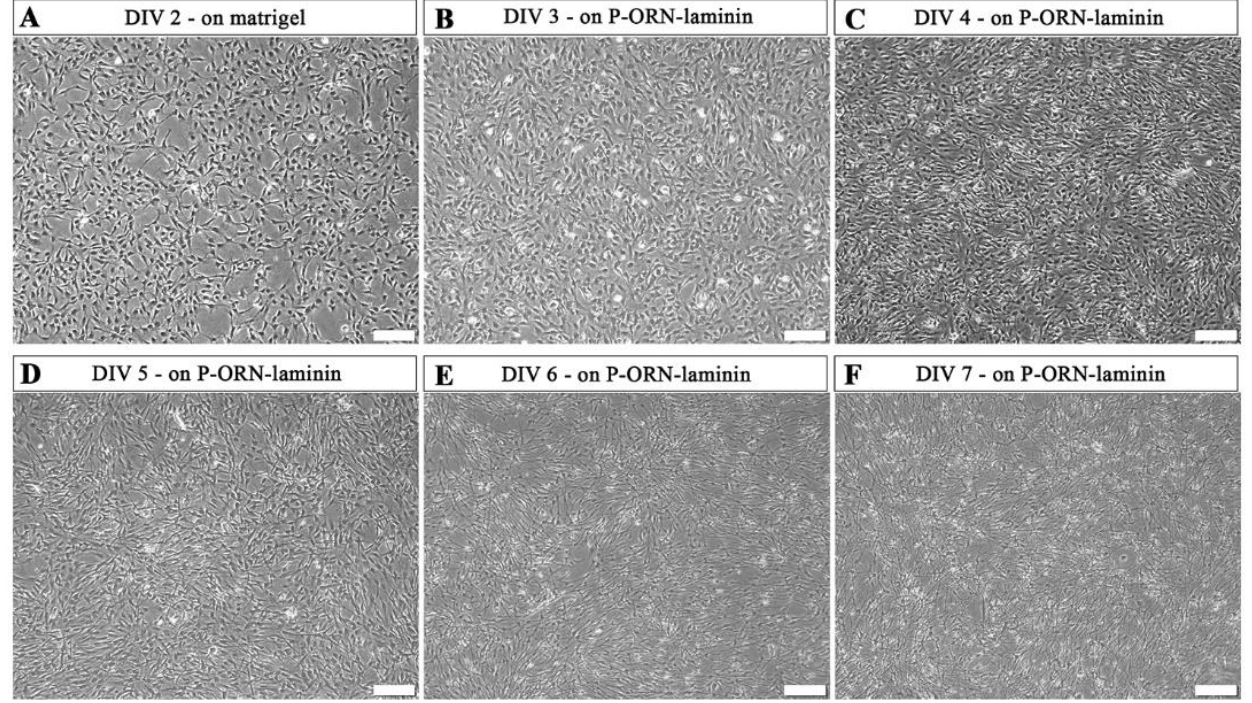
Figure 3. Representative phase-contrast photomicrographs of hiPSC-immatureSCs undergoing differentiation to hiPSC-SCs. hiPSC-immatureSCs cultured in MHH-SCDM after 2 days on matrigel coating (( A ), DIV 2) and after the coating was changed to poly-L-ornithine (P-ORN)-laminin ( B – F ). Cell num- bers continuously increased with a lowering pace and started showing an elongated morphology at DIV 3 ( B ) and DIV 4 ( C ). After this, cells visibly differentiated more instead of further increasing their density at DIV 5 ( D ). At DIV 6 ( E ) and DIV 7 ( F ), most of the cells showed an elongated morphology. Differentiation was coming to an end at DIV 7 ( F ), when undifferentiated cells were not observed within the cultures. Scale bar: 200 µ m. MHH-SCDM = Schwann cell differentiation medium as composed by the MHH